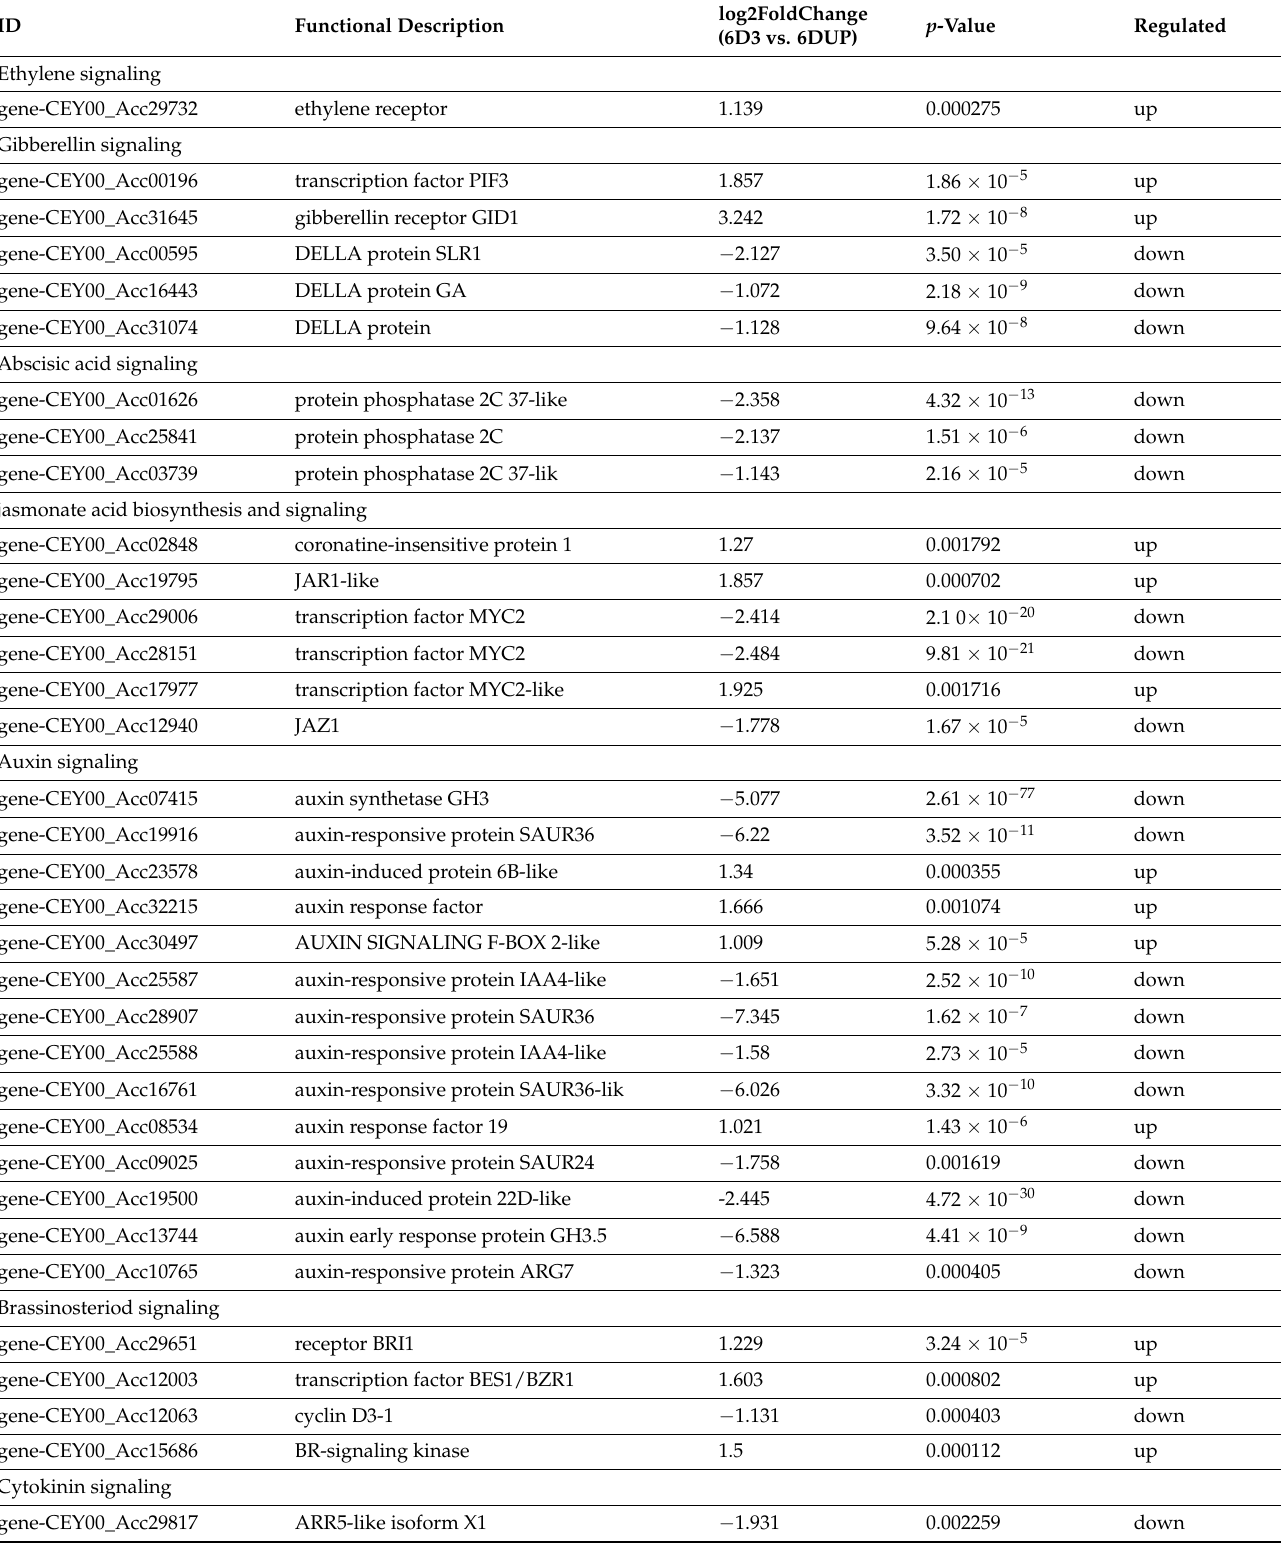
Table 4. List of DEGs involved in phytohormone biosynthetic and signaling in kiwifruit ( Actinidia chinensis ) ‘Donghong’ in response to 14-OH BR